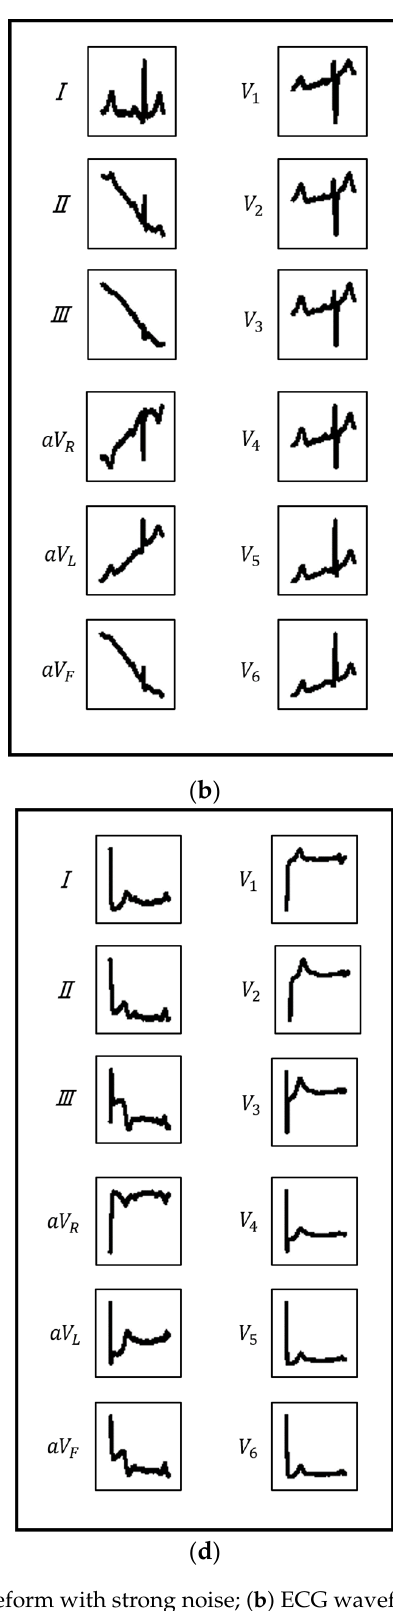
Figure 3. Misclassified ECG waveforms: ( a ) ECG waveform with strong noise; ( b ) ECG waveform with strong trend; ( c ) ECG waveform with two beats; and ( d ) ECG waveform with most of the beat missing.